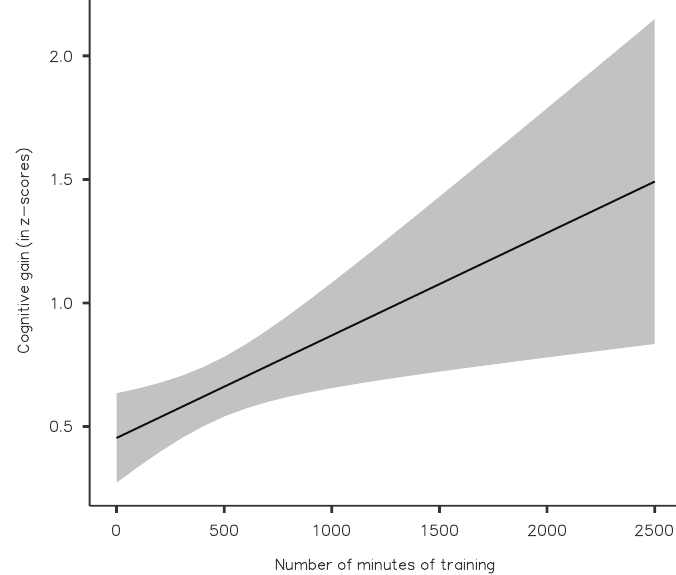
Figure 2. Relationship between minutes of training and cognitive gain (in z-scores). The black line represents the regression line, and the 95% confidence intervals are presented in